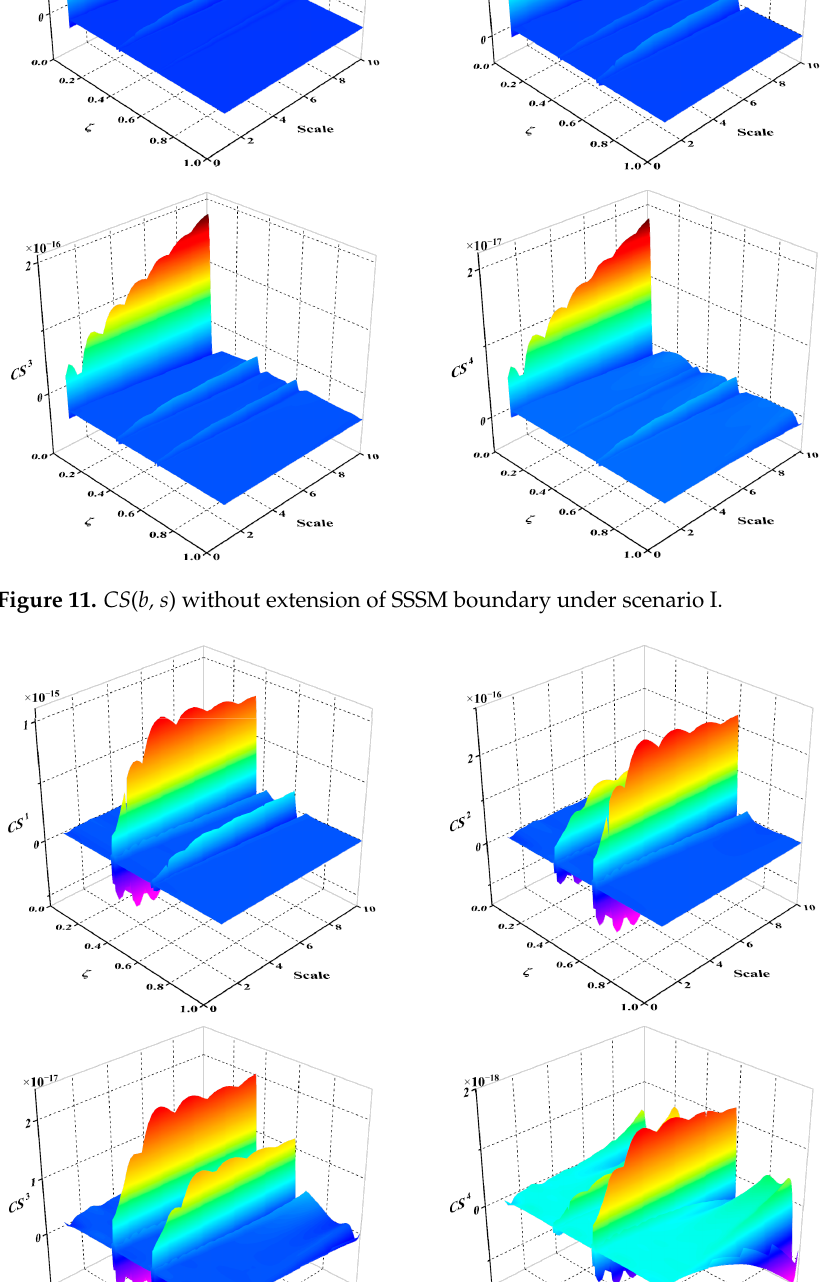
Figure 13. Damage identification results under scenario I: ( a ) CS (cid:3364)(cid:3364)(cid:3364)(cid:3364) ( b , s ); ( b ) Damage index SSSM DI . 0.0